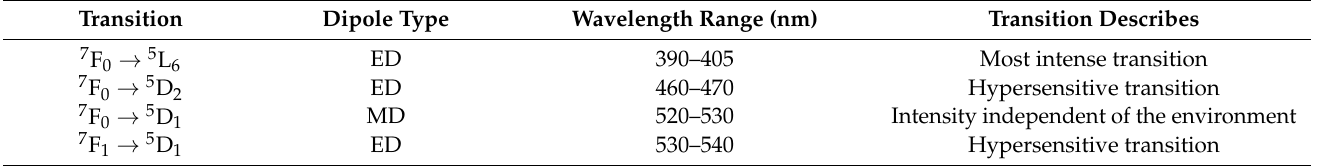
Figure 2. Excitation spectra, monitoring at 590 nm. Table 2. The chosen transitions of Eu 3+